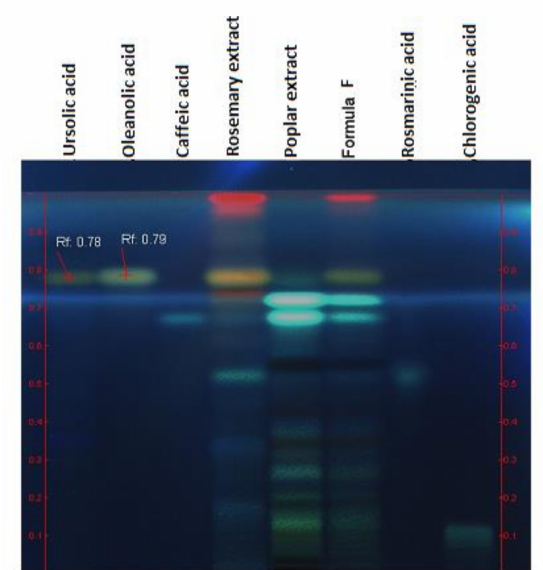
Figure 2. Identification of triterpenic and polyphenolcarboxylic acids; derivatization with p -anisaldehyde, UV 366 nm.